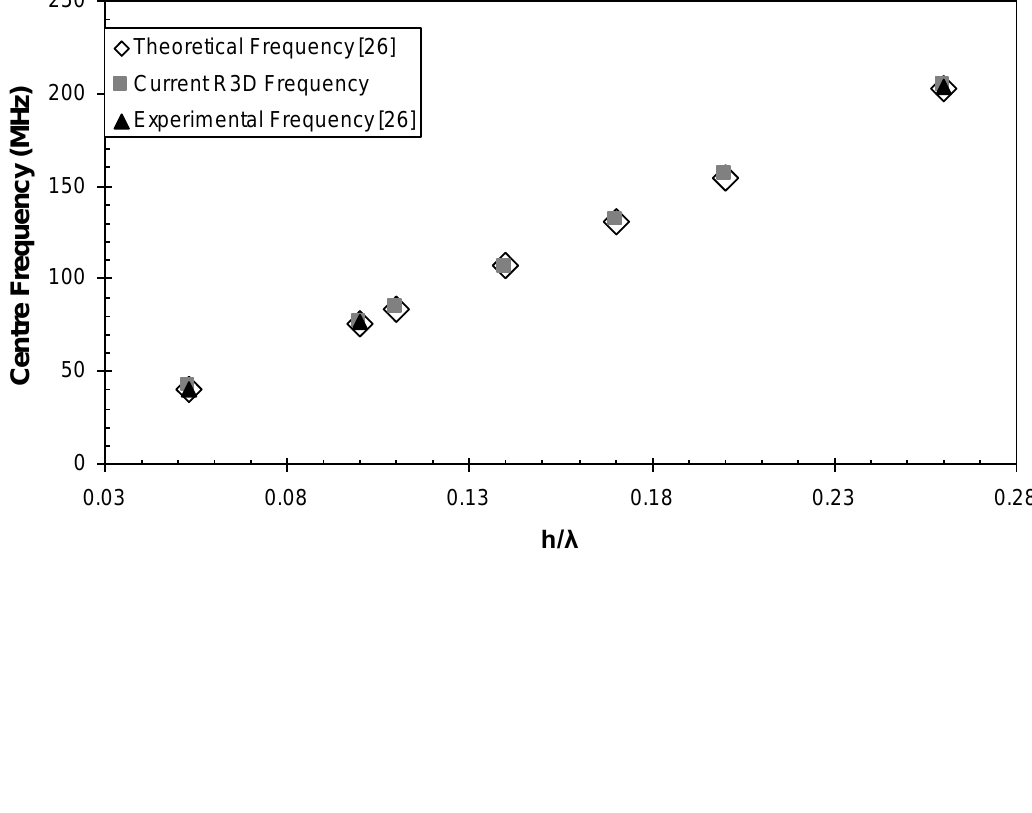
Figure 11. Comparison of the centre frequency values of the current R3D FE model with theoretical and experimental frequency